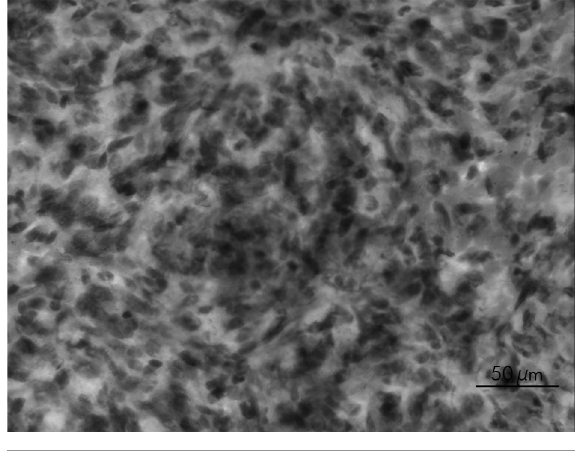
Figure 6. Presence of multinucleated atypical cells on the smears, with a sugestive report of mesenchimal malignat neoplasia (H&E stain).